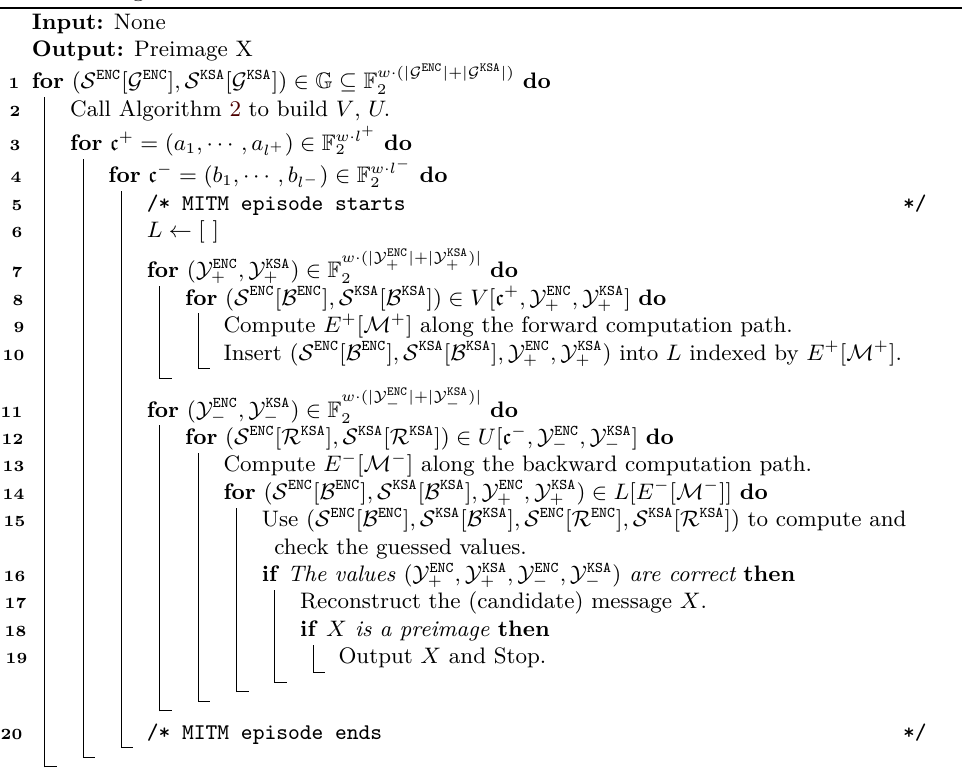
Algorithm 3: The MITM preimage attack with nonlinearly constrained neutral words and